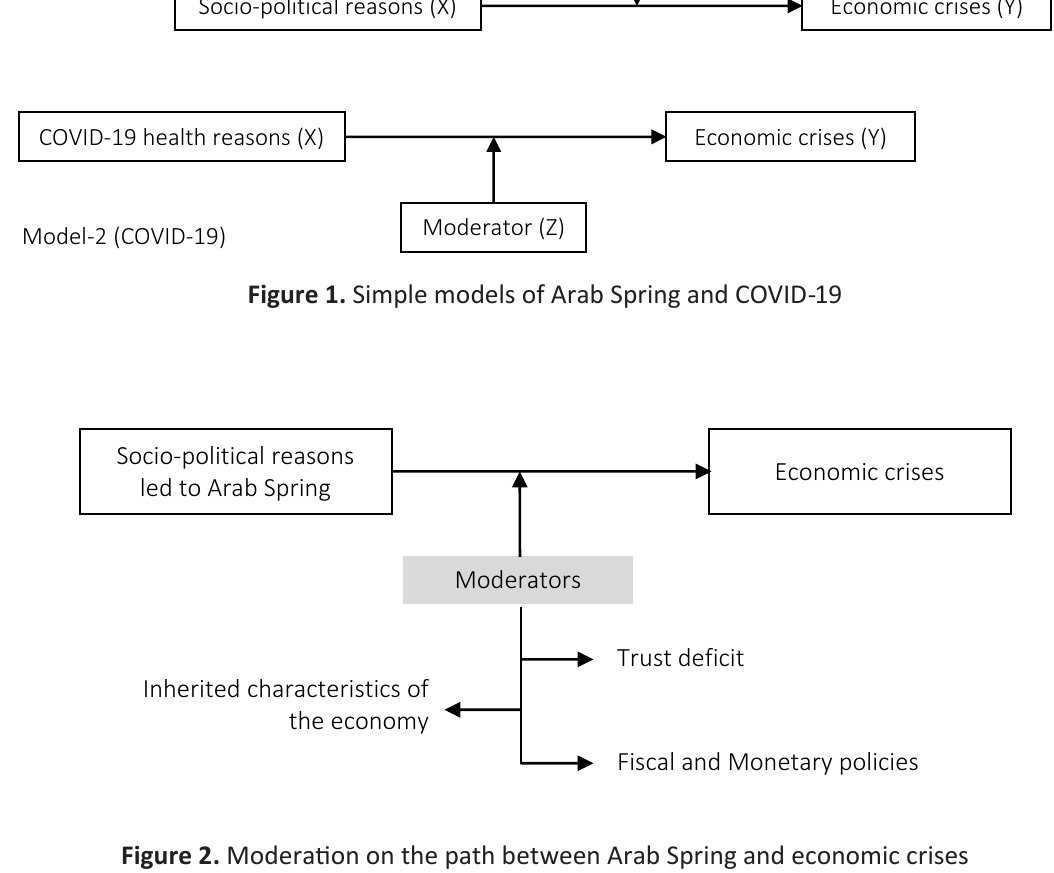
Figure 2. Moderation on the path between Arab Spring and economic crises